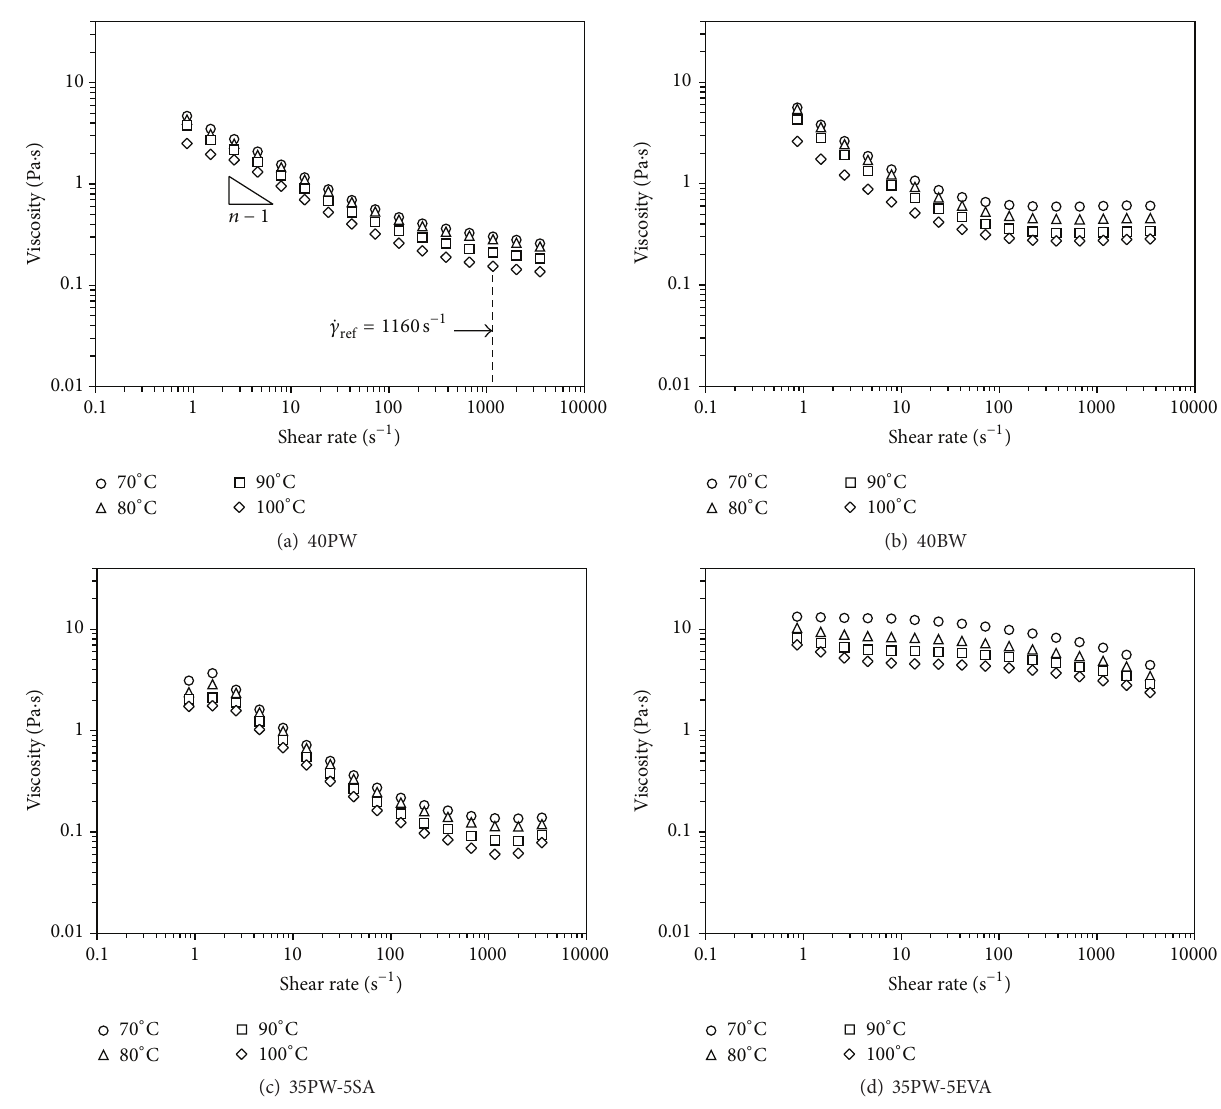
Figure 4: Viscosity profiles of feedstocks at different